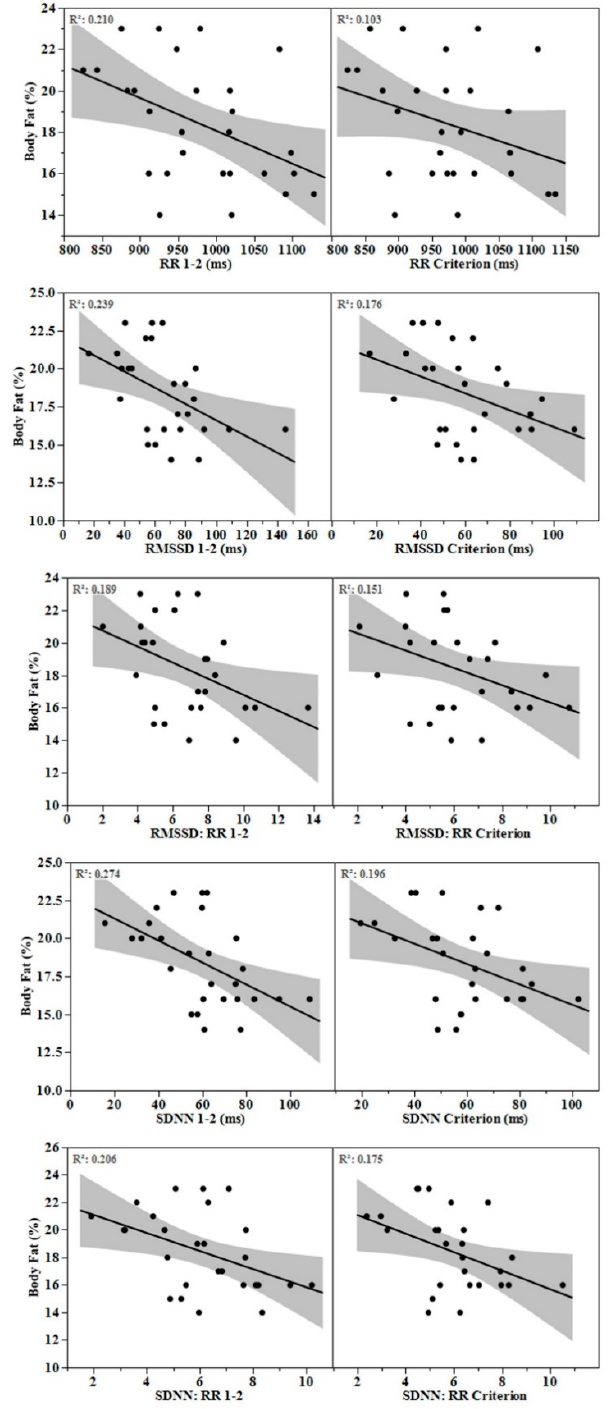
Figure 1. Scatterplots featuring association between body fat percentage and heart rate variability parameters derived from the 1–2 min and criterion segments.